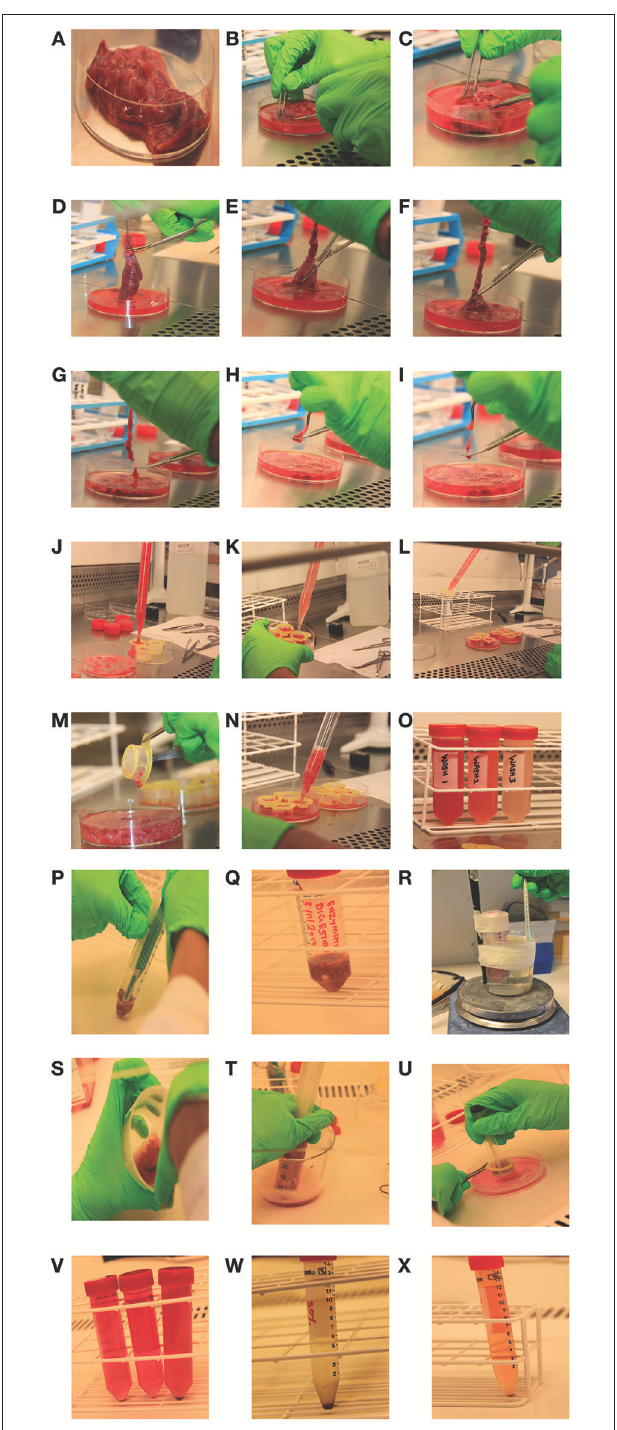
FIGURE 1 | Human lung tissue processing: pictures taken during different steps of WEMP protocol. (A–C) Washing tissue, removing blood pockets. (D–I) Cutting tissue into thin strips and then into small pieces. (J–O) Washing and filtering uniformly cut pieces with PBS. (P) Processing tissue pieces with scalpel. (Q,R) Enzymatic digestion of tissue pieces at 37 ◦ C with magnetic stirrer. (S–V) Mechanical disruption of digested tissue using syringe. (W,X) Percoll gradient centrifugation and RBC